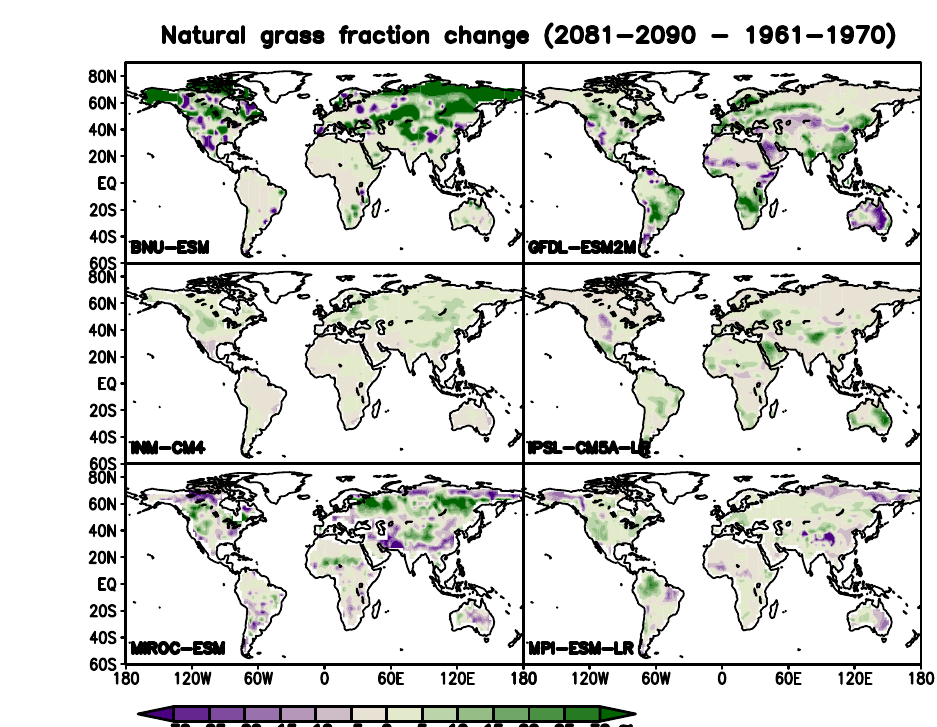
Figure 12. Changes of natural grass fractions between future (2081–2090) and historical (1961–1970) periods from six CMIP5 ESMs. The values represent fractional cover changes relative to the whole grid cell, instead of relative change of natural grass cover. Notable increase over the northern high latitude regions is found for